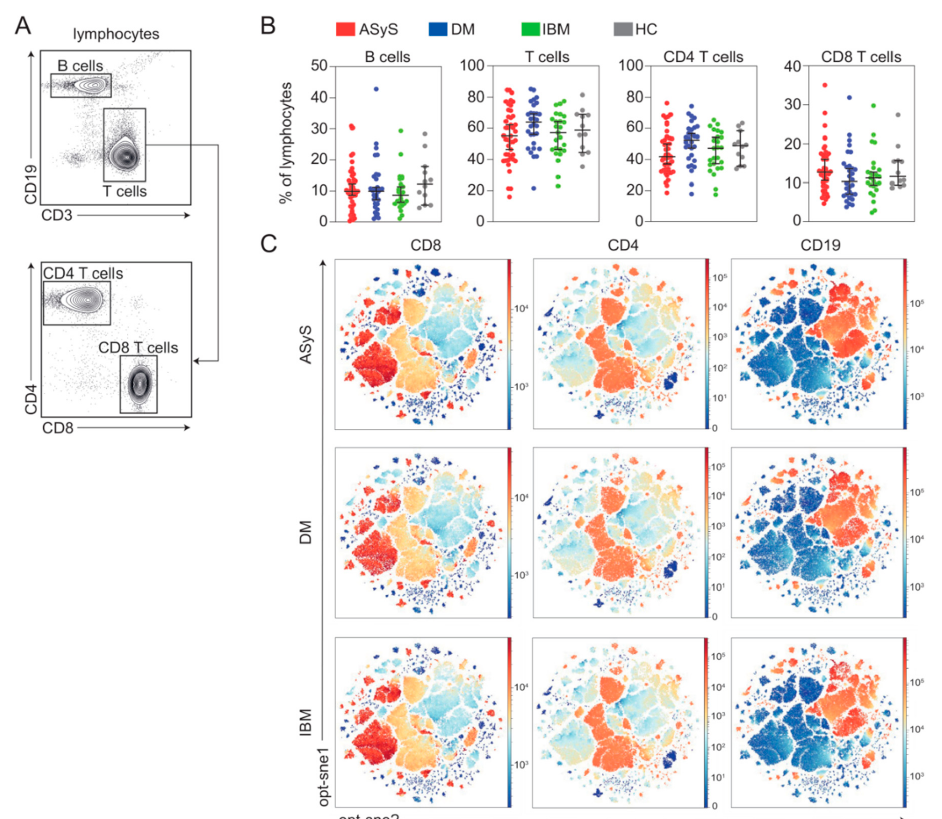
Figure 2. Broad immune cell patterns are unchanged in IIM. ( A ) Representative flow cytometry gating strategy for immune cell subsets. ( B ) Frequencies of broad immune cell subsets in IIM and in healthy controls. ( C ) Global optimization of tSNE (opt-sne) projection of CD8, CD4 and B cells (CD19) for all patients concatenated and overlaid. Expression of indicated proteins is colour coded. Each point represents an individual ASyS (red), DM (blue), IBM (green) patient or healthy controls (grey). Abbreviations: ASyS = anti-synthetase syndrome; DM = dermatomyositis; IBM = inclusion body myositis; tSNE = t-distributed stochastic neighbour embedding.